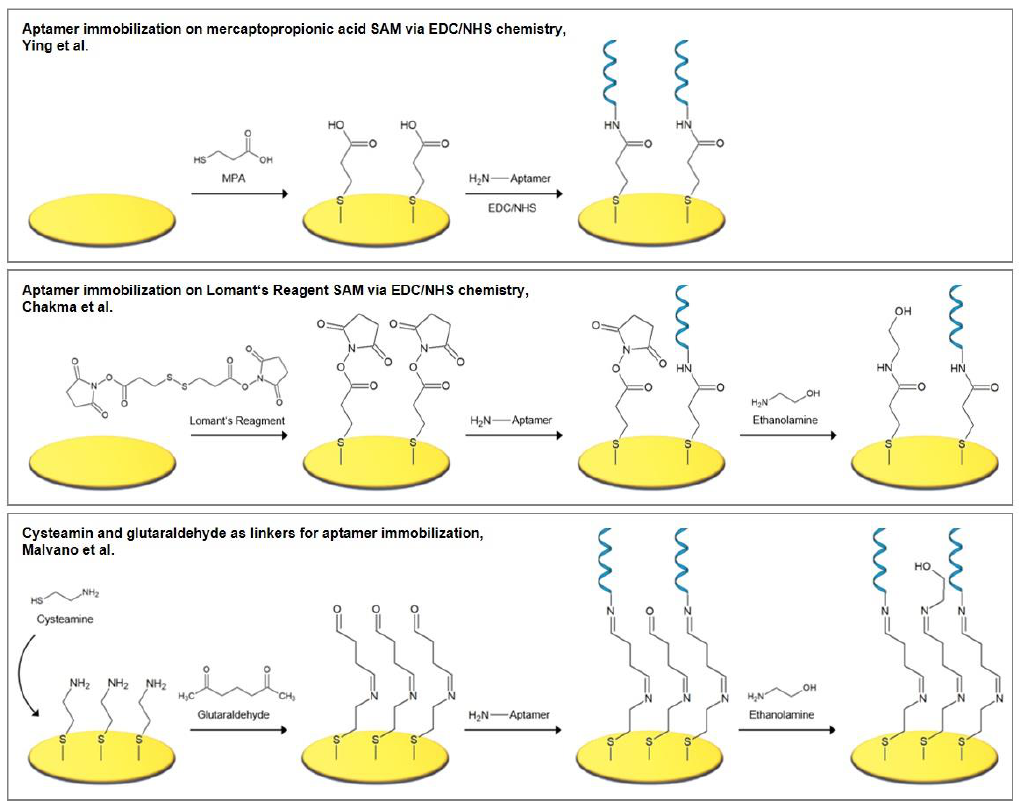
Figure 5. Recently employed short linkers for the immobilization of aminated aptamers